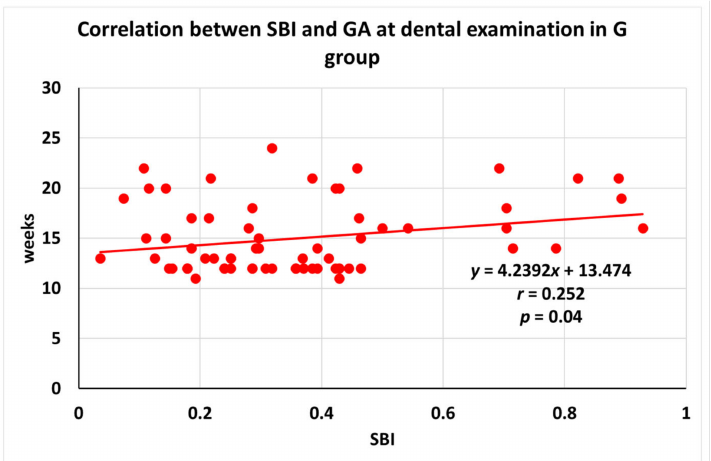
Figure 2. Correlation between SBI and GA at dental examination in the G group. Results are shown as means ( ± SD). G = gingivitis; GA = gestational age; SBI = sulcus bleeding index; n = 111; and p < 0.05 was considered statistically significant. Table 2. Correlation between SBI and GA at periodontal examination in different dental status groups; p < 0.05 was considered statistically significant. Group N Correlation Coefficient p